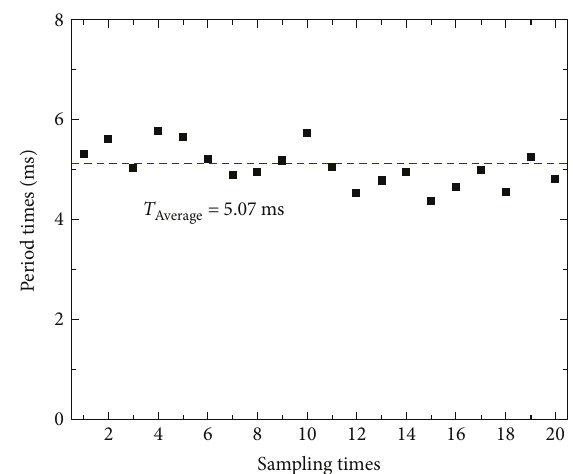
Figure 7: The speed of the wake fl ow in the sample. Reynolds number =800, the diameter=2 mm, the sheet position =3mm, and the distance between the cylinder and the slot was 5.9cm. The jet direction was at an angle of 45 ° to the surface of the fl at.